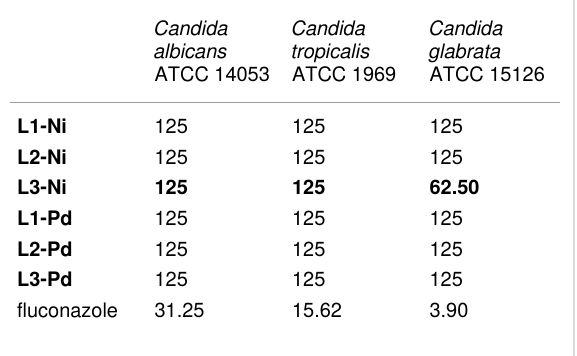
Table 2: Antifungal activity ( μ